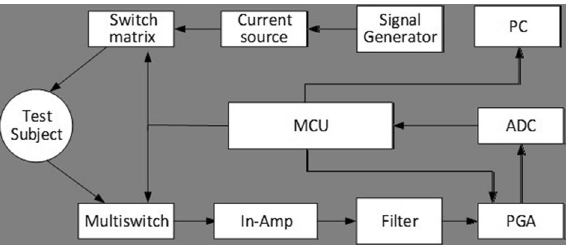
Figure 1. Overall design of the system. PC personal computer, ADC analog–digital converter, PGA programmable gain amplifier, MCU microcontroller unit, In-Amp instrumentation amplifier.